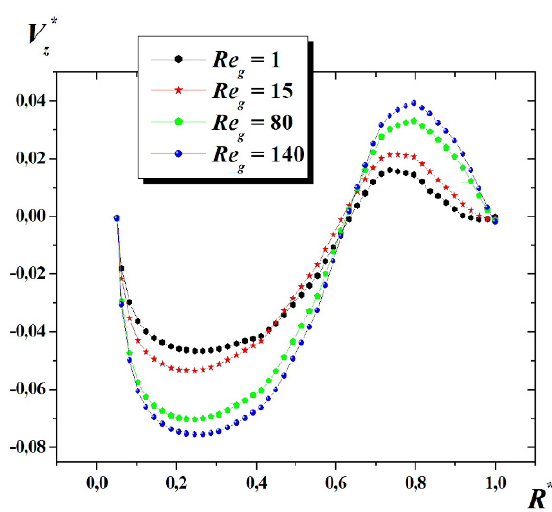
Figure 13. Axial velocity for double helical ribbon impeller, at n = 0.4, θ